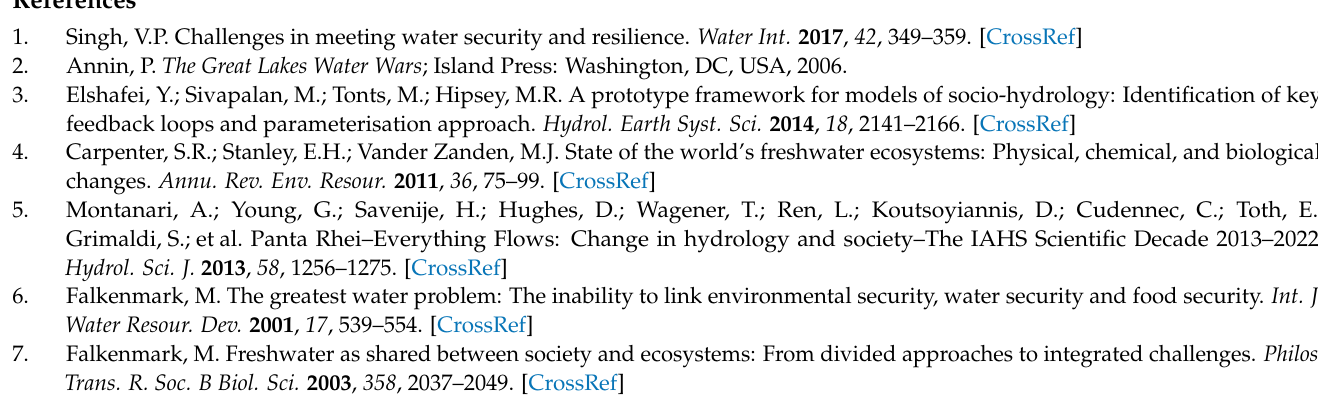
Table S2: The most local cited documents, Figure S1: Trending of publications over time, 1972–2021, Figure S2: Distributions of documents by subject area, 1972–2021, Figure S3: The most productive sources and their cite scores in last 10 years, Figure S4 The most used keywords dynamics over time based on annual occurrences, Figure S5: The most used keywords dynamics over time based on cumulative